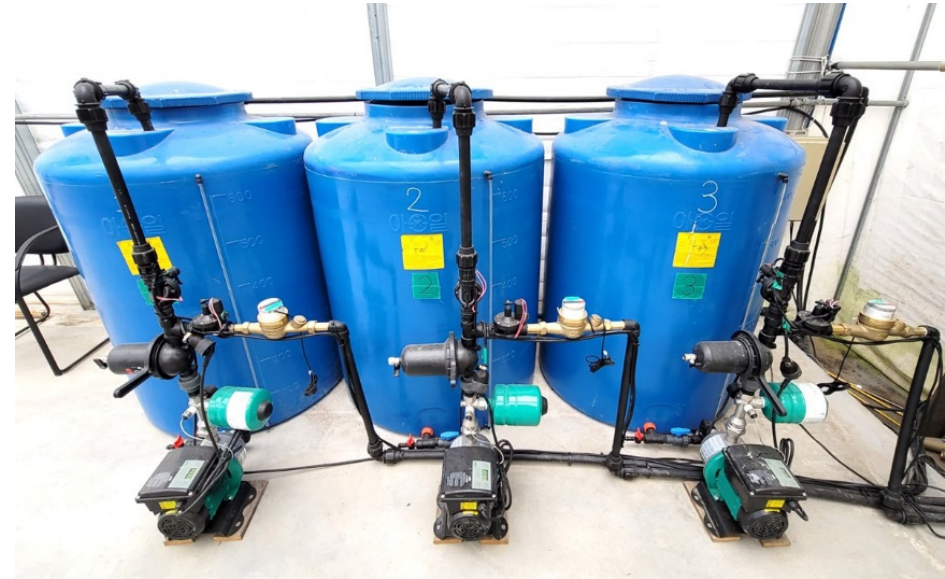
Figure 4. The photo of the pressure pumps and solenoid valves in the experimental field.